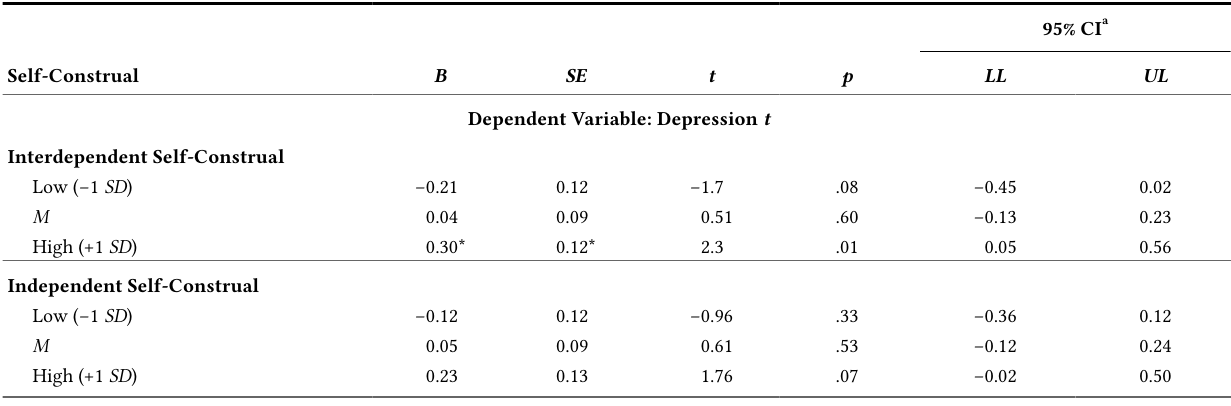
Bootstrapping Results for Moderation Effects of Interdependent/Independent Self-Construal on the Relationship of Perceived Discrimination to Depression and Anxiety